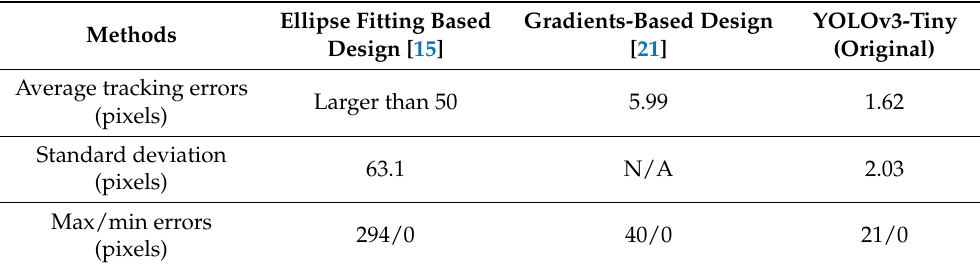
Table 4. Comparisons of the visible-light pupils’ center tracking errors between the YOLOv3-tiny and the previous ellipse fitting based designs.